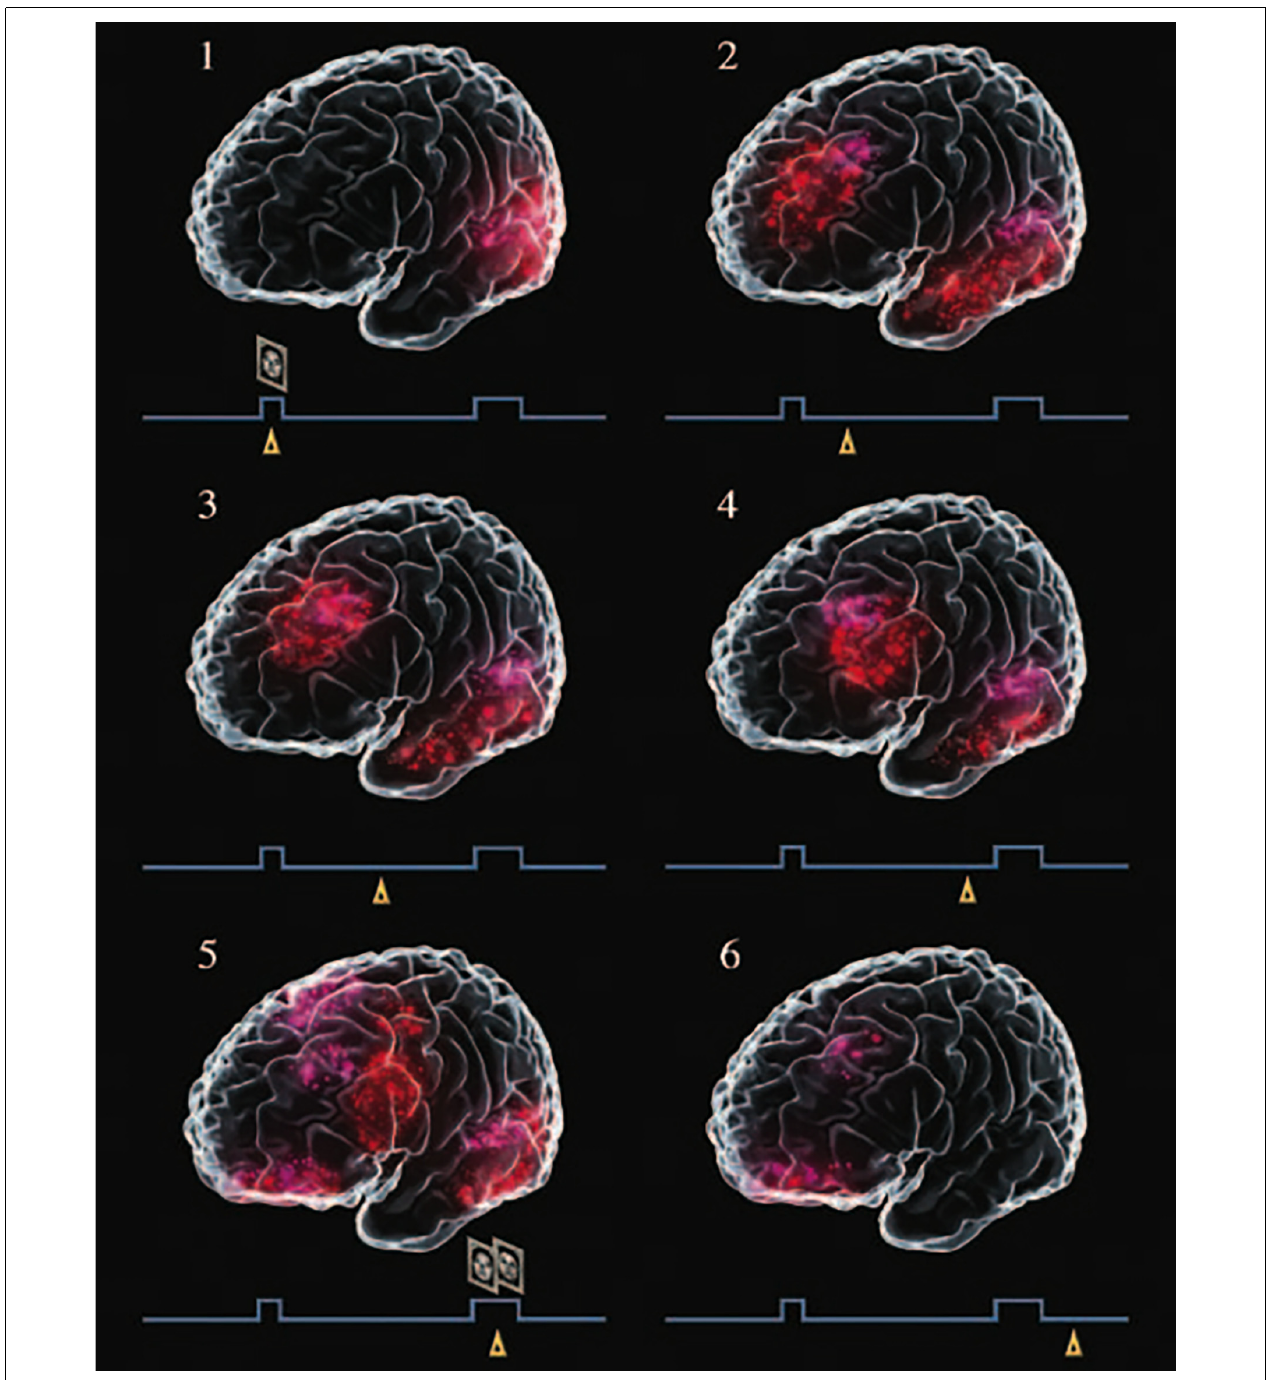
FIGURE 3 | Graphic meta-analysis of cortical activations in the course of a delayed matching-to-sample task, paradigmatic of visual delay tasks in a large number of functional neuroimaging studies. A trial begins with the presentation of a face (sample), which the subject must remember for a delay of 10–15 s, at the end of which the subject is presented with two faces and must choose the sample. Little triangles mark the approximate relative timing of the records in the course of a trial. Note the activation of the visual cortex at the sample (excerpt 1), and of the inferior temporal and prefrontal cortices during the delay (excerpts 2–6). From Fuster